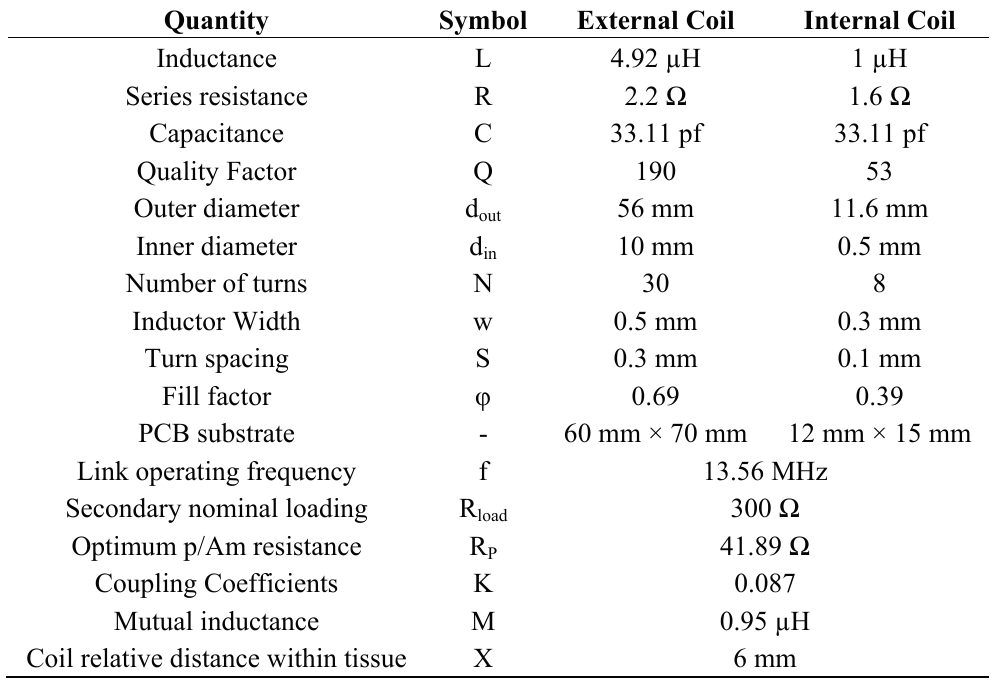
Table 1. The values and parameters of the external and internal